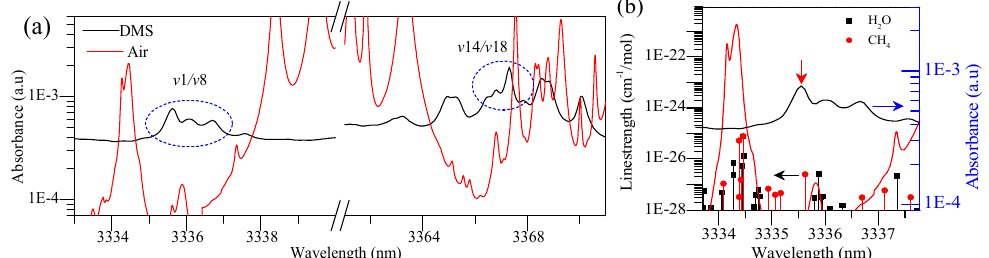
Figure 1. ( a ) Absorption spectra of 5 ppm × m DMS (PNNL database) and air model (H 2 O: 1.860000%, CO 2 : 0.033000%, O 3 : 0.000003%, N 2 O: 0.000032%, CO: 0.000015%, CH 4 : 0.000170%, O 2 : 20.900001%,